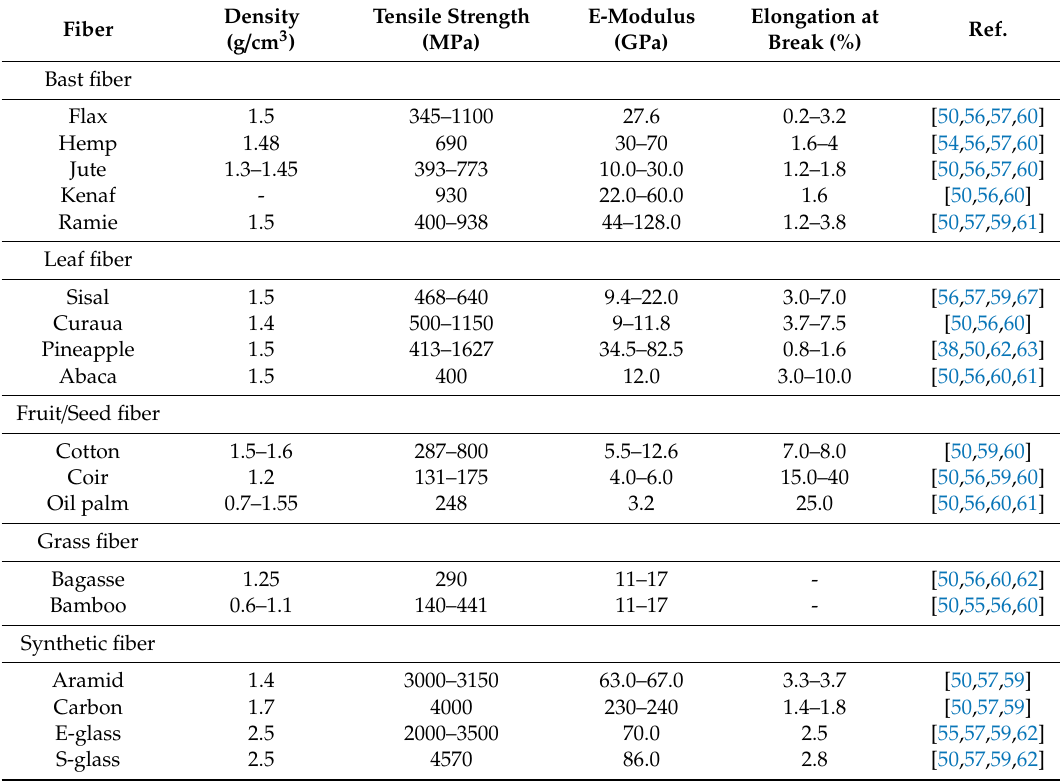
Table 2. Mechanical properties of some natural and synthetic fibers.